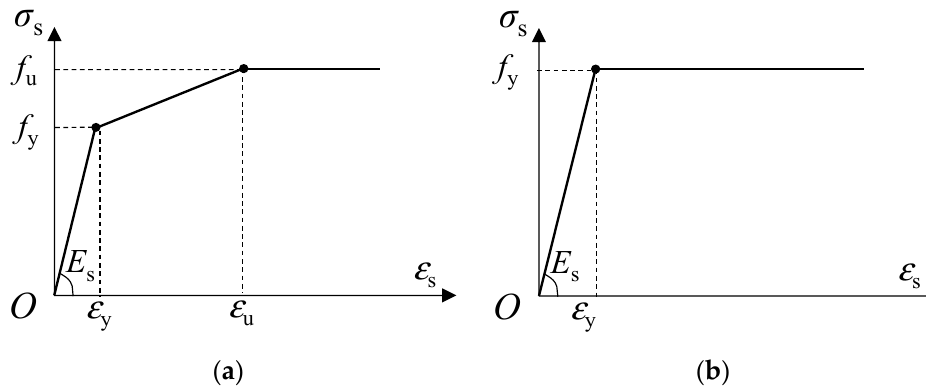
Figure 9. Steel material model for: ( a ) Headed stud; ( b ) Structural steel and reinforcing steel.